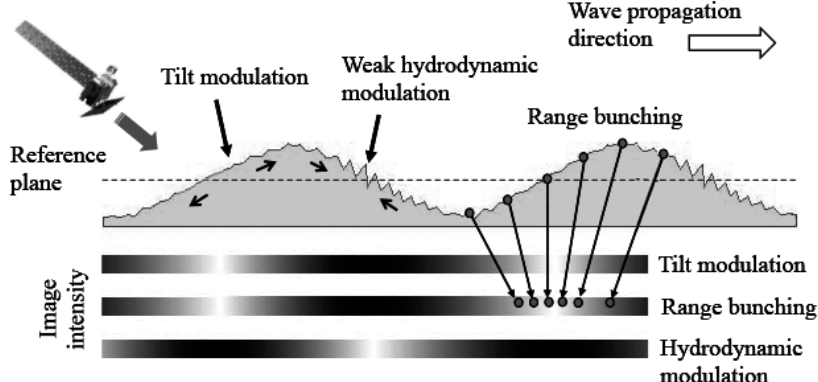
Figure 3. Illustration of the imaging processes of range–traveling ocean waves by the tilt, weak hy- drodynamic and foreshortening modulations.